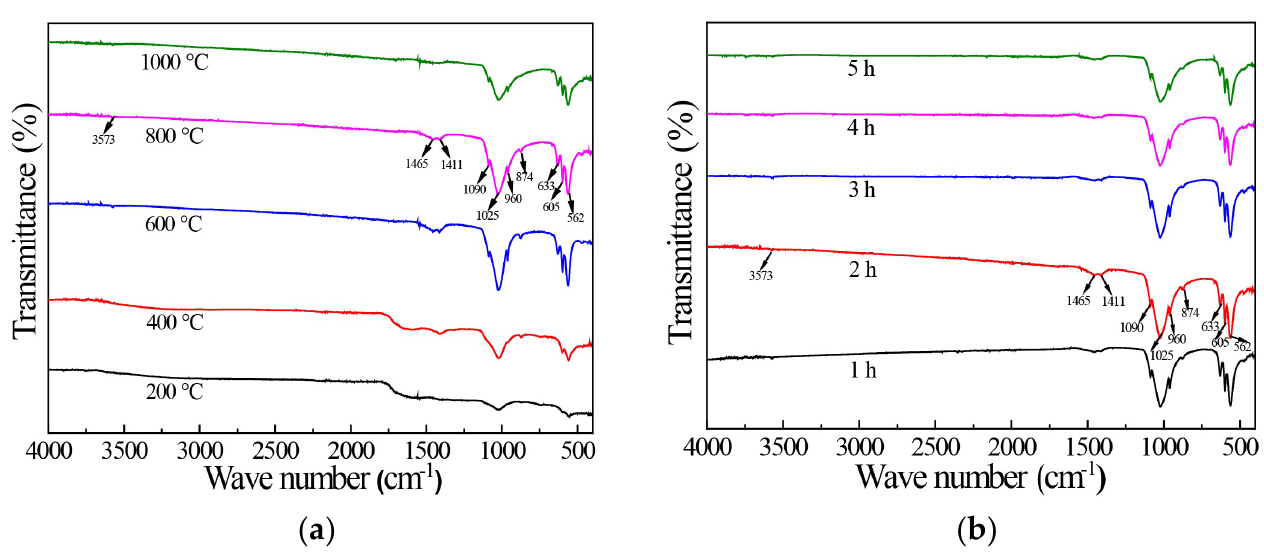
Figure 1. ( a ) XRD of HAP prepared at different calcination temperatures; ( b ) XRD patterns of HAP samples prepared under different calcination time.